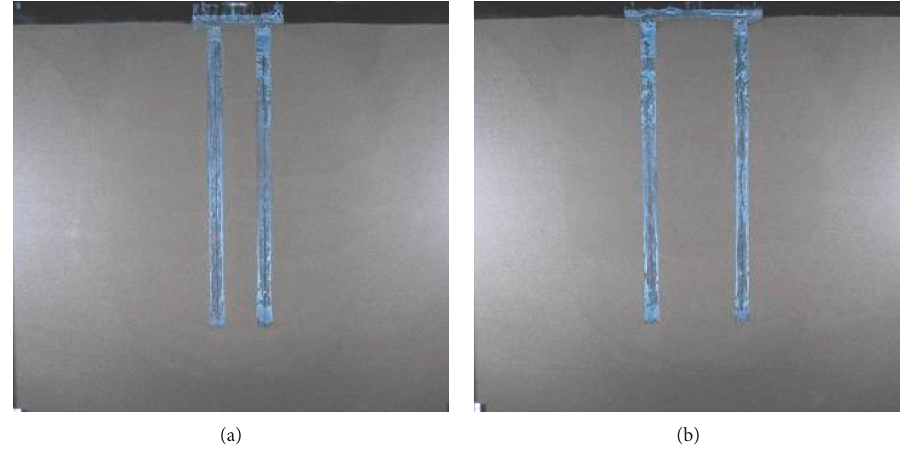
Figure 4: In situ images of the pile groups. (a) 3 b pile spacing. (b) 6 b pile spacing.